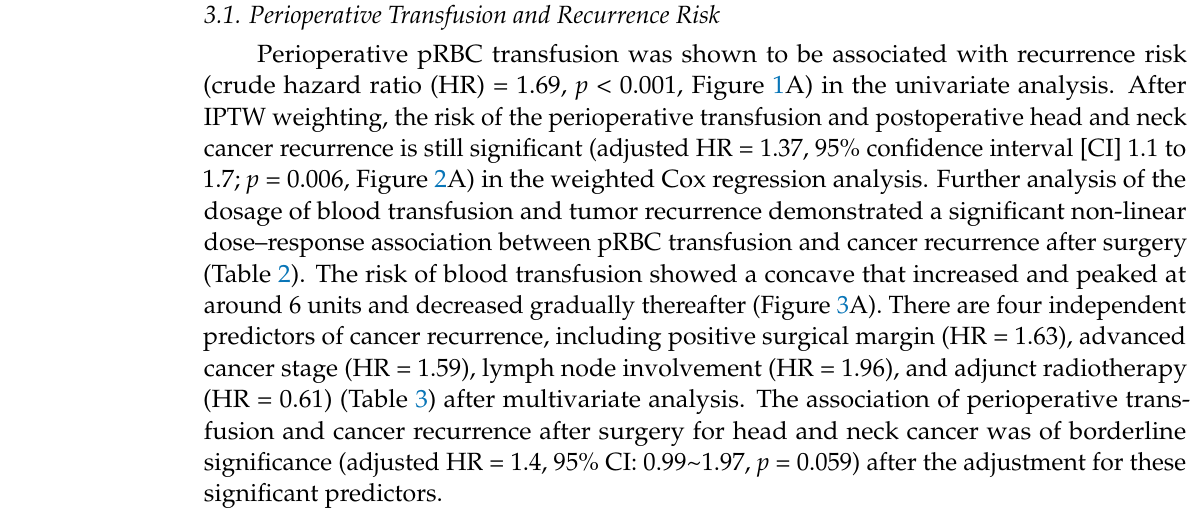
Table 2. The linear and non-linear relationship between perioperative transfusion and recurrence-free and overall